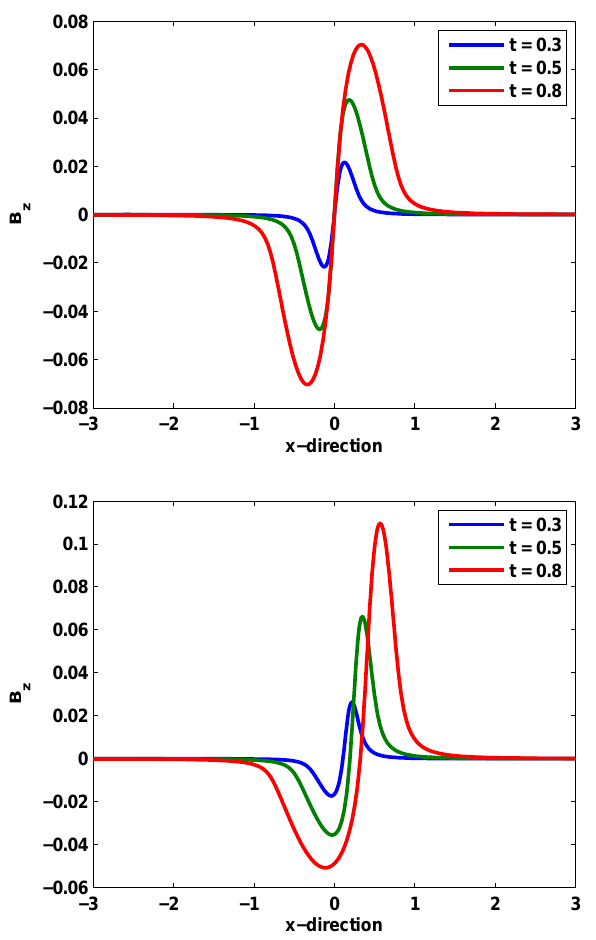
Fig. 8. Behavior of the magnetic field x –component in the inflow region. In the upper panel, the assumption U = 0 holds, whereas in the lower panel, the case U = 0 : 5 v A is shown. Both functions are calculated for t = 2 . Besides the magnetic field strength, the actual positions of the field reversal regions are shown. The dot represents the final position of the reconnection line again. B x is blown up by the factor 10 for a better visibility.